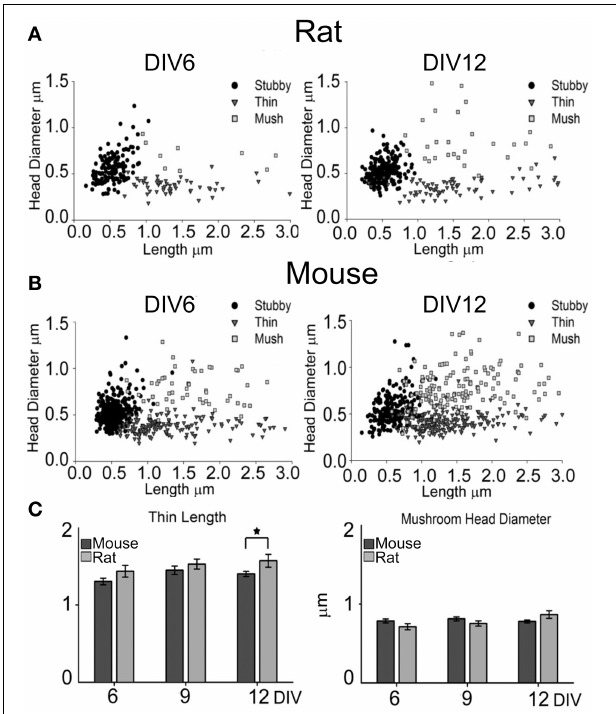
FIGURE 3 | Spine measurements and categorization at DIV6 and DIV12. Scatter plots representation for rat (A) and mouse (B) neurons. X-axis represents the length of each spine, while the y-axis shows the head diameter. Sorting of spine type was performed by operator during measurements; circle: stubby, triangle: thin and square: mushroom spines. ( N = 15 fields from different neurons from 3–4 different cultures). (C) Average length ( ± SE) of thin spines and average ( ± SE) head diameter of mushroom spines at DIV6, 9 and 12 for mouse (dark gray bars) and rat (light gray bars) neurons. Student t -test ∗ P ≤